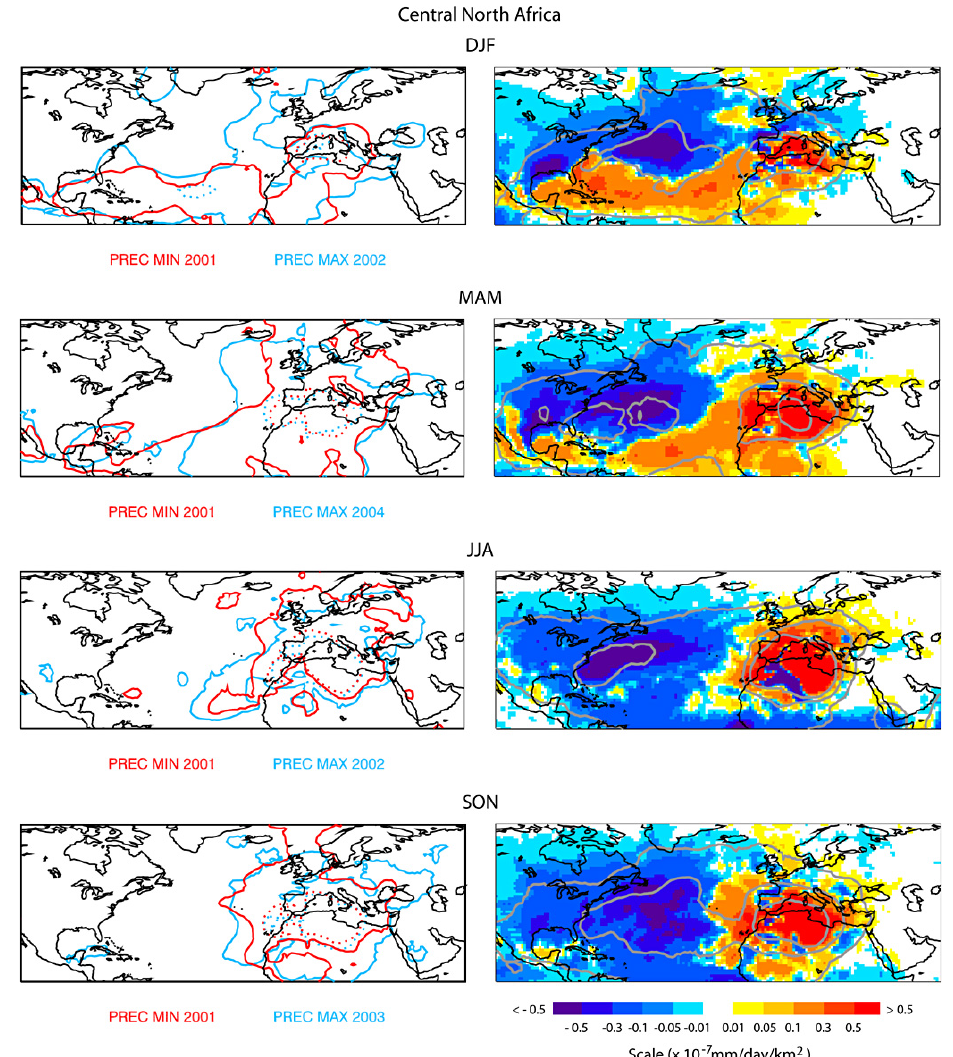
Fig. 8. As Fig. 2, but for the Central North Africa subregion (CA), considering its equivalent area as 1052890km 2